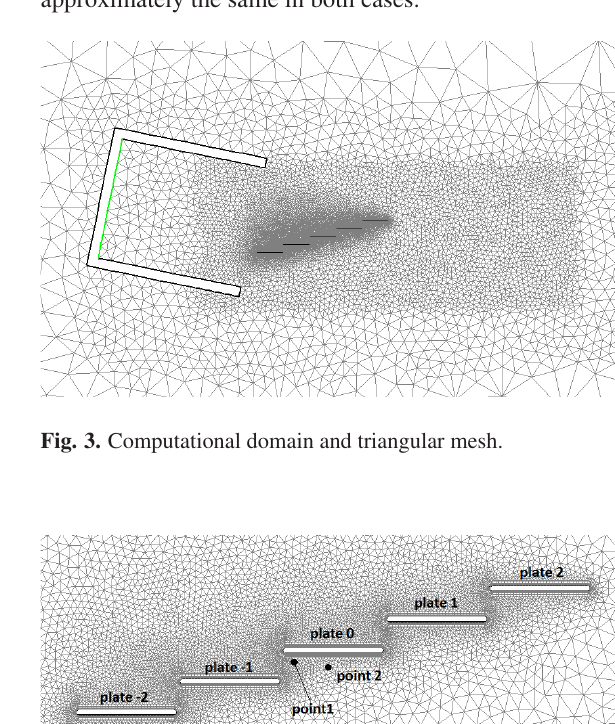
Fig. 4. Detail of computational mesh in the vicinity of simplified cascade.